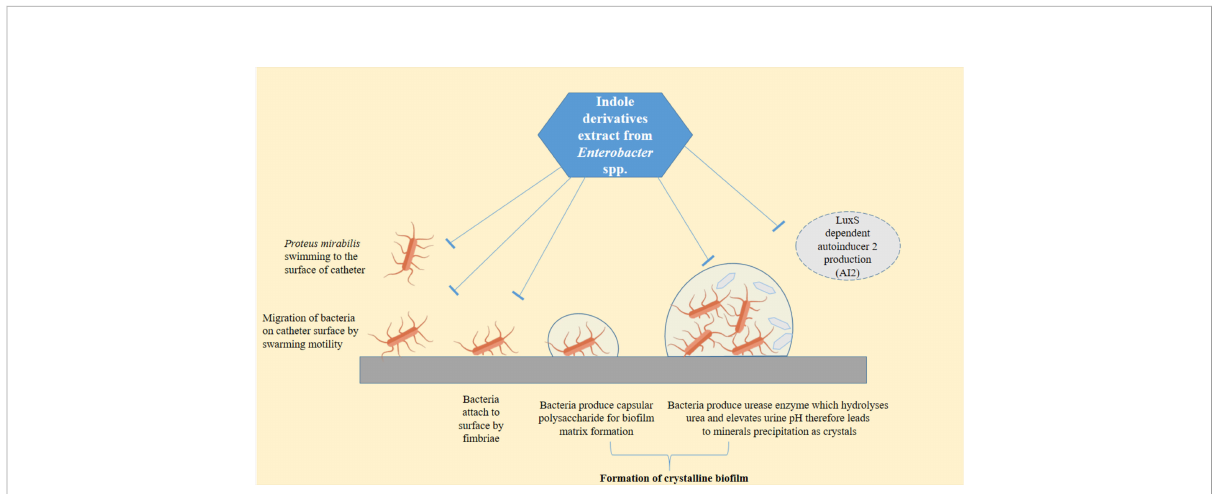
FIGURE 6 Schematic diagram summarizing steps of bio fi lm formation by P. mirabilis on urinary catheter and the effects of the indole derivative extract from the supernatant of Enterobacter sp. at the phenotypic and molecular levels. In this fi gure, lines was designed with bar-headed end indicate repression of gene expression or repression of a phenotype. Used vector of fl agellated bacteria designed by Freepik